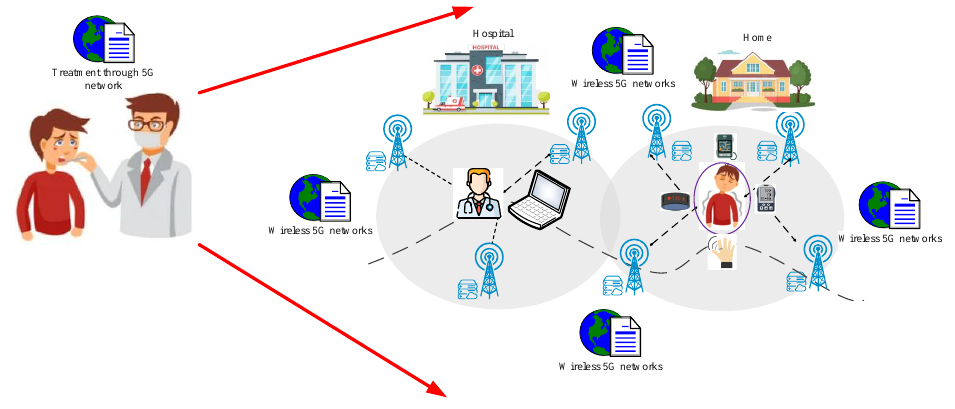
Figure 2. Use of 5G technology to remotely treating